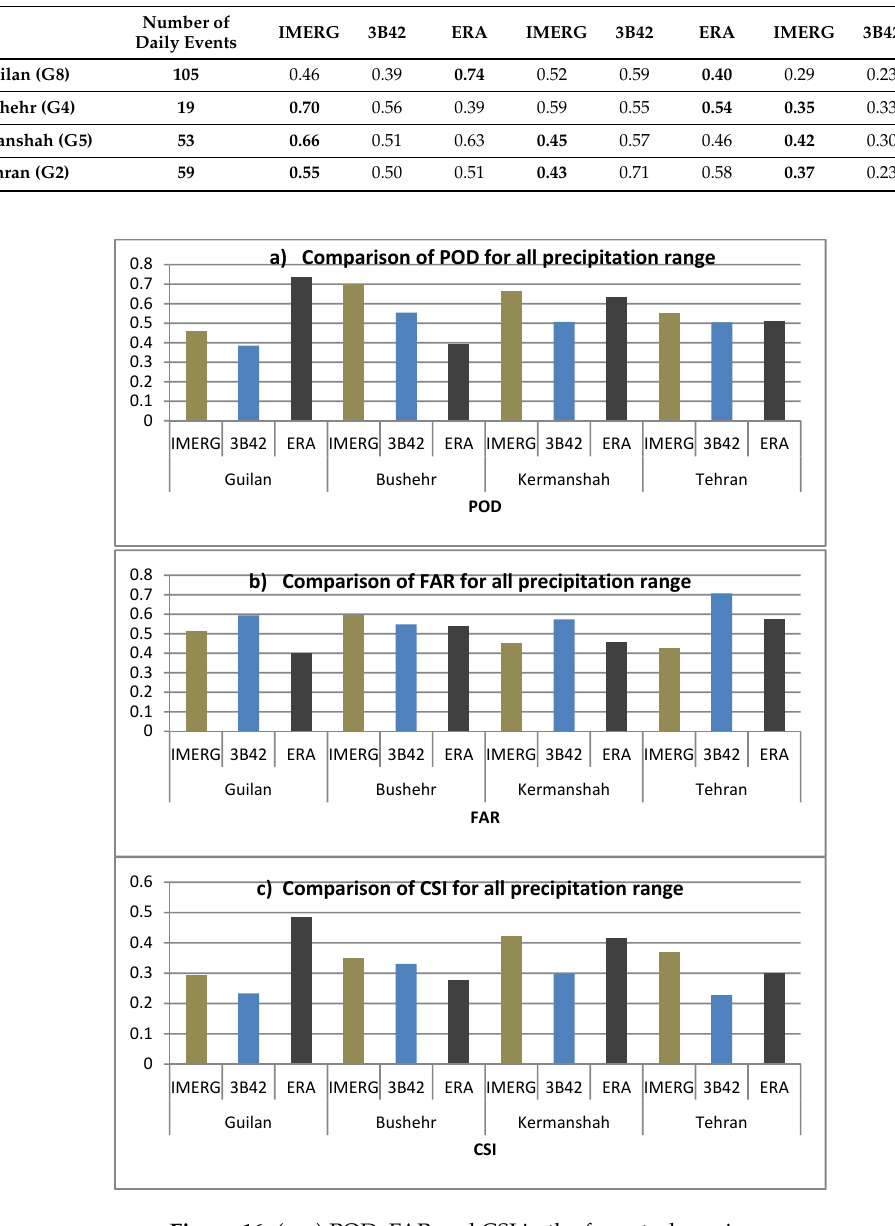
Figure 16. ( a – c ) POD, FAR and CSI in the four study regions.